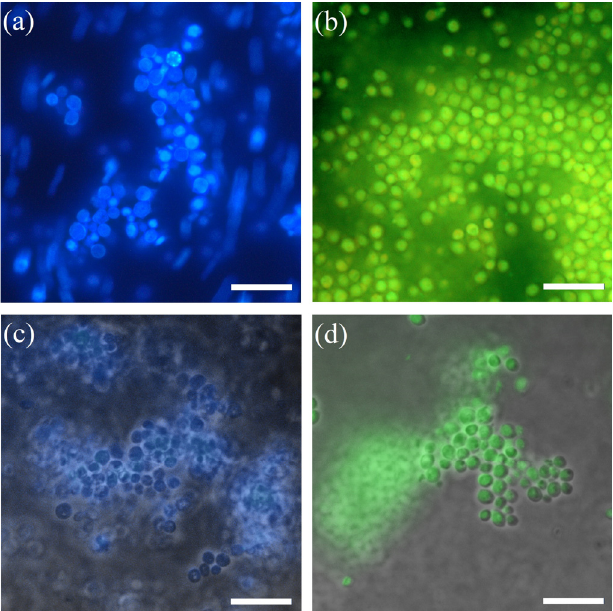
Figure 5. Fluorescence microscopy: ( a , b ) suspension of yeast Ogataea polymorpha VKM Y-2559; ( c , d ) slice of STP EG -composite matrix with immobilized yeast Ogataea polymorpha VKM Y-2559; ( a , c ) cytochemical coloring of the yeast cell wall by fluorescent dye Calcofluor White; and ( b , d ) cytochemical coloring of the yeast by fluorescent dye Live/Dead Yeast Viability Kit. The bar represents a 10 µm scale.